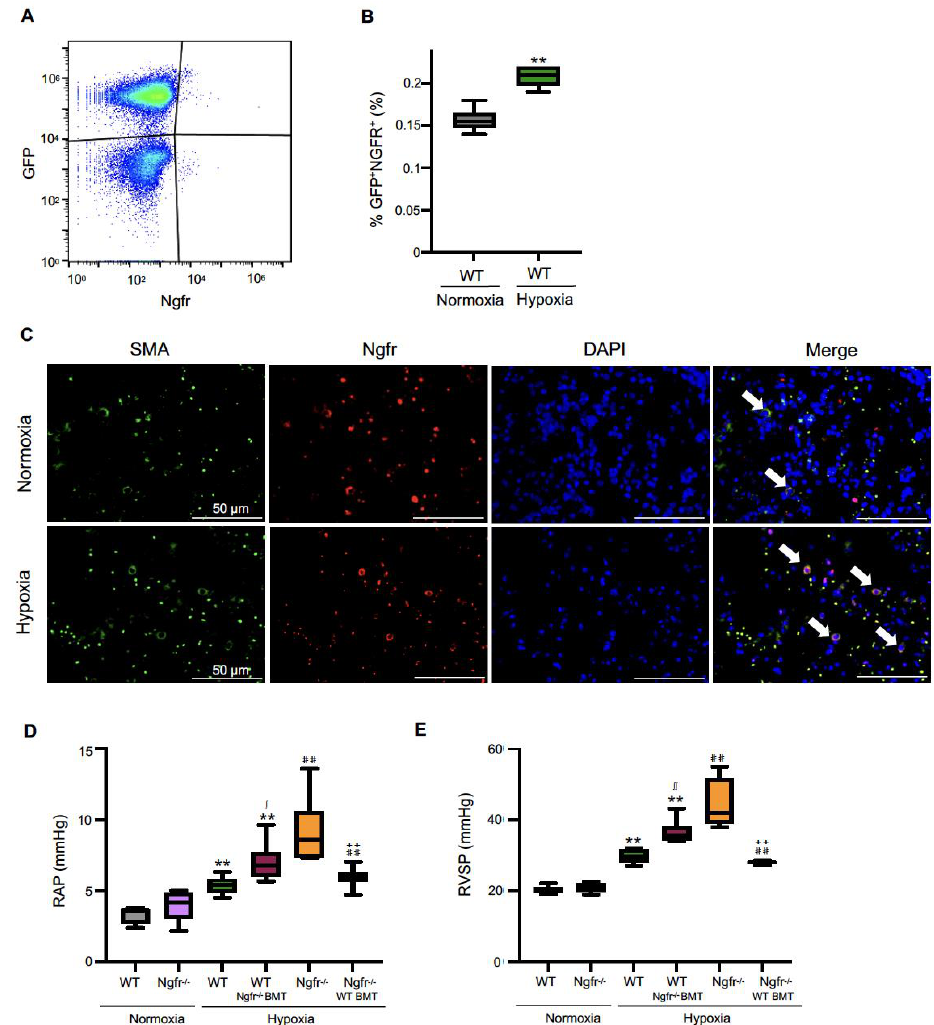
Figure 4. BM-specific depletion of Ngfr exacerbates hypoxia-induced pulmonary hypertension. ( A ) Representative flow cytometric figure (GFP+ Ngfr+ cells in lung tissue obtained from GFP-Tg BM-WT mice under hypoxic conditions). ( B ) The frequencies of GFP+ Ngfr+ double positive cells in lung tissue (% GFP+ Ngfr+) obtained from GFP-Tg BM-WT mice under normoxic and hypoxic conditions. ( C ) Immunofluorescence in the lung tissue of WT mice transplanted with GFP-Tg BM under normoxic and hypoxic conditions was used to assess the movement of circulating Ngfr-positive cells. GFP+Ngfr+ cells are indicated with white arrows (green: GFP, red: Ngfr, blue: DAPI, and